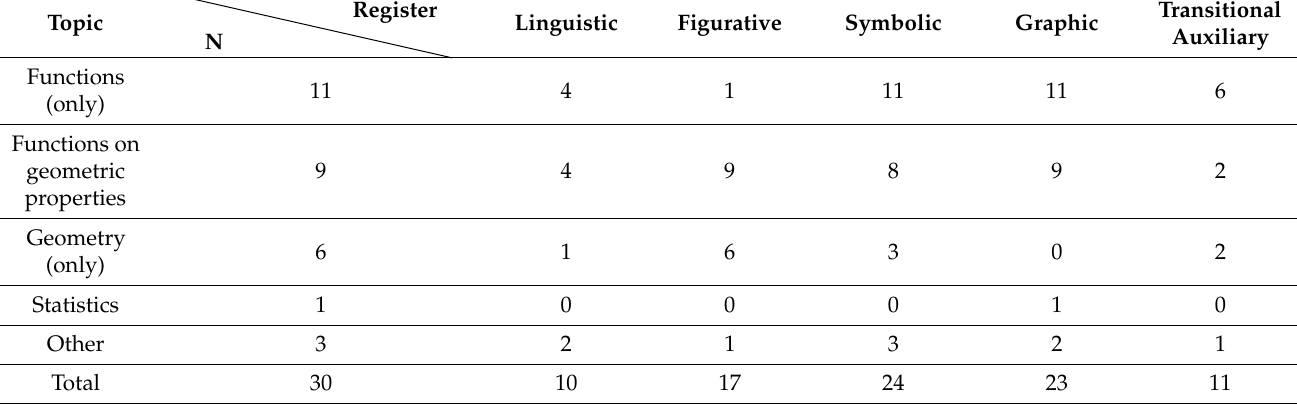
Table 2. Overview of the relations between topics and registers in play for the included